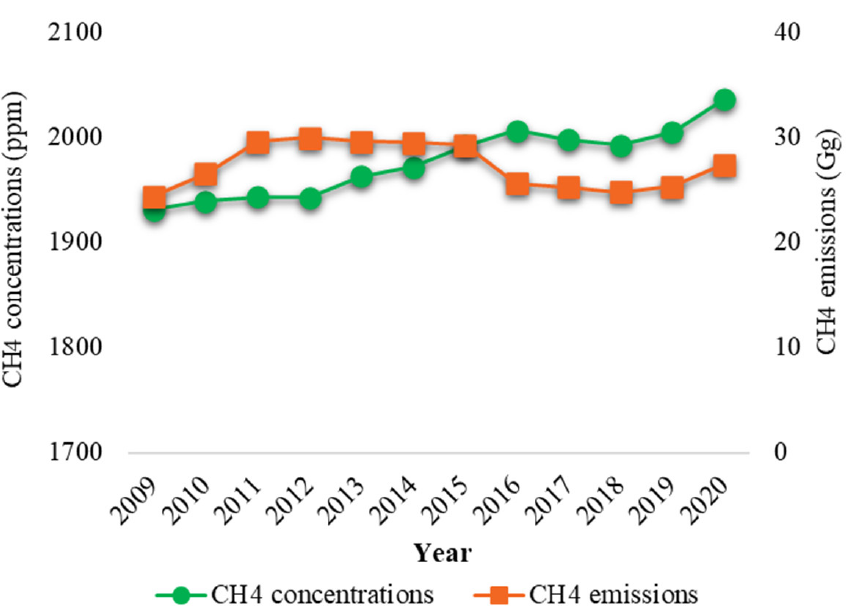
Figure 7. CH 4 concentrations and emissions in Heilongjiang province, 2009–2019.